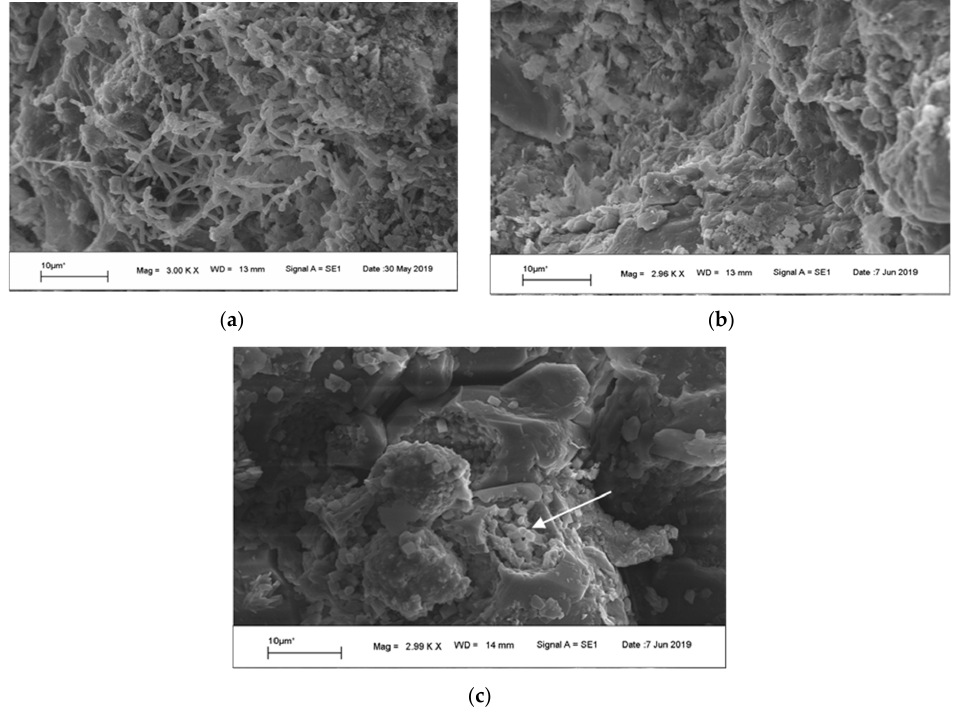
Figure 3. Scanning Electron Microscopy (SEM) images of sandstone samples: ( a ) the surface of sandstone dust covered with hyphae; ( b ) the weathered surface of a sandstone plate; ( c ) single bacterial cells located in the pit etched in the surface of sandstone (arrow).